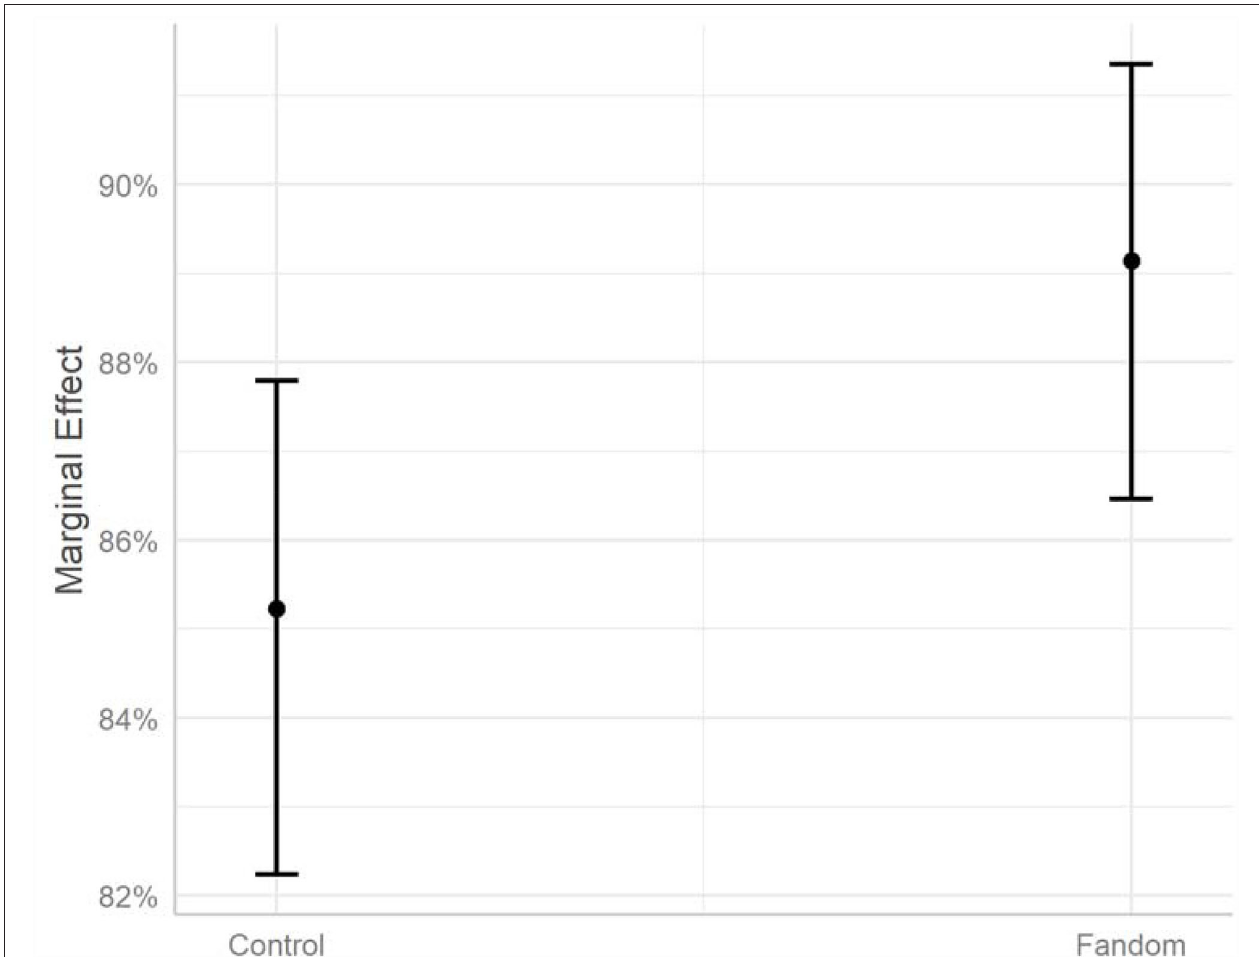
FIGURE 10 | Effect of celebrity idol and fandom community combined on mobilizing donation.